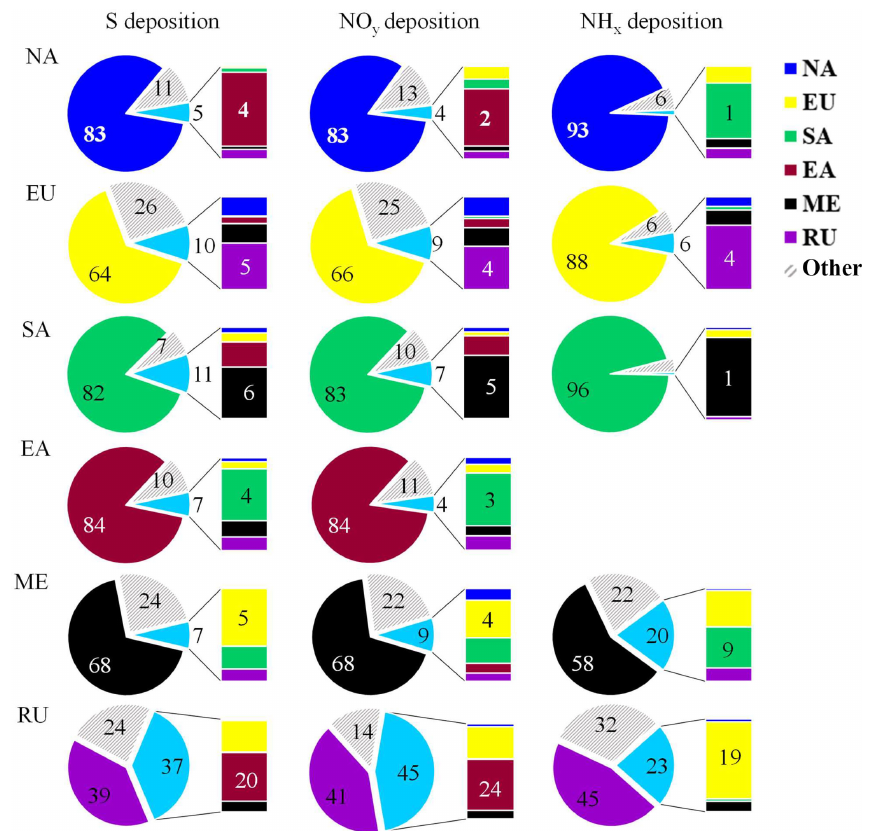
Figure 6. Source contribution to S and N deposition from the hemispheric transport from foreign regions and from own-region emissions. Other (OTH, pattern fill) is the contribution by other reasons than the total effects of separate emission reduction of the six regions (see manuscript for